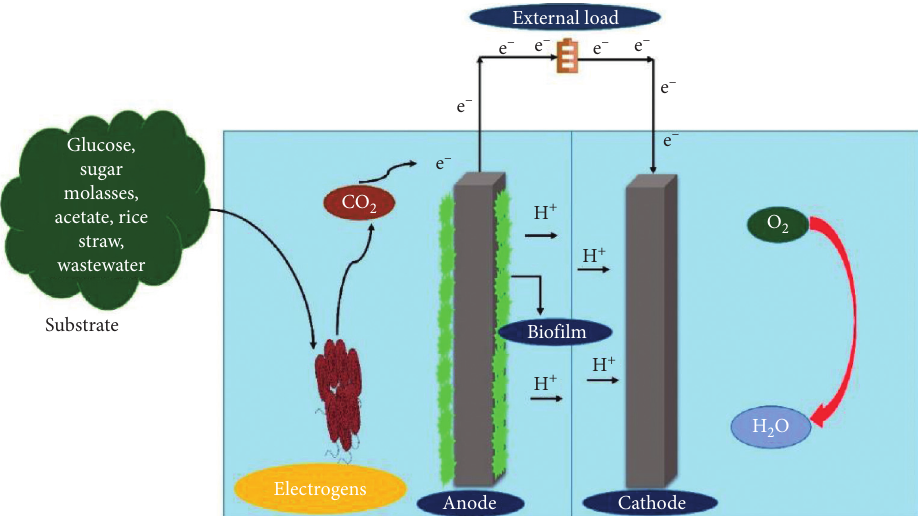
Figure 1: Systematic presentation of MFC (adapted from reference [15] with MDPI permission). Table 1: Summary of the used substrates in MFC with